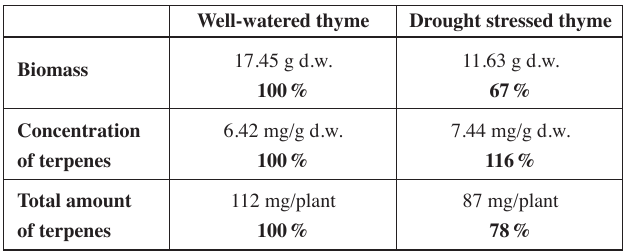
Tab. 1: Biomasses, concentrations and total amounts of terpenes in well- watered ( ≙ 100 %) and drought stressed thyme plants after nine weeks of cultivation under the respective conditions ( K lein - wächter et al., 2015